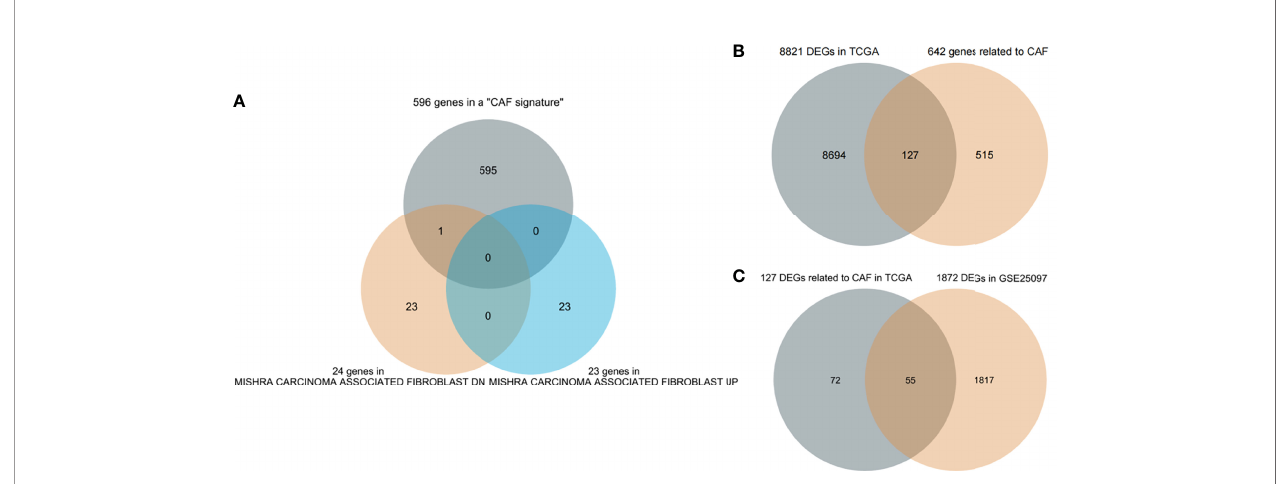
FIGURE 1 | Screening genes (A) Three cancer-associated fi broblast (CAF)-related gene sets intersect to fi lter overlapping genes. (B) CAF-related DEGs in The Cancer Genome Atlas (TCGA). (C) Further validation in